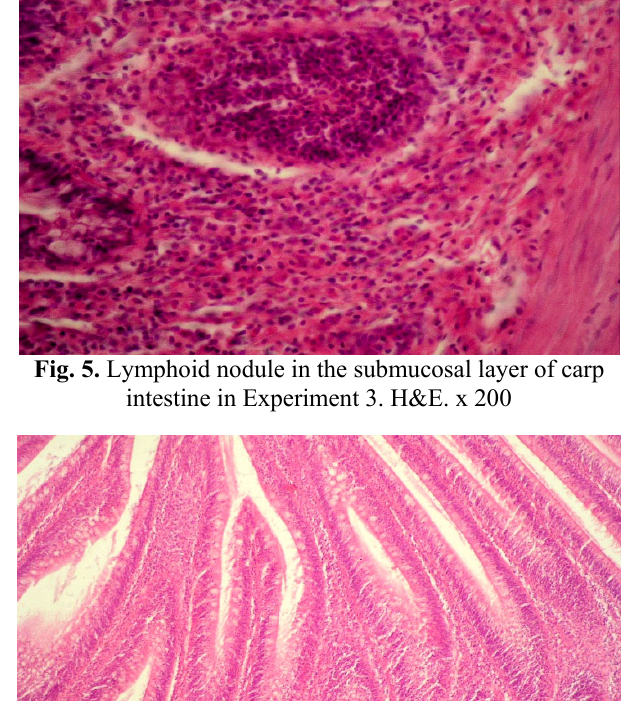
Fig. 8. Destructive changes of villi of carp intestinal mucosa in Control. H&E. x 200